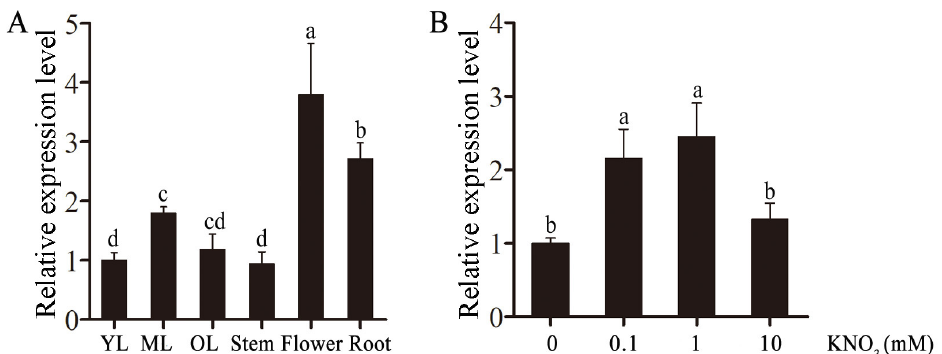
Figure 2. The relative expression of CsLBD39 in tea plant. ( A ) The relative expression levels of CsLBD39 in different developmental stages and tissues. ( B ) The relative expression levels of CsLBD39 in the root after adding 0.1, 1, 10 mM KNO 3 to N-limited tea plant seedlings. The data are expressed as mean ± standard deviation of three replicates ( n = 3). Different lowercase letters indicate significant differences at p < 0.05.